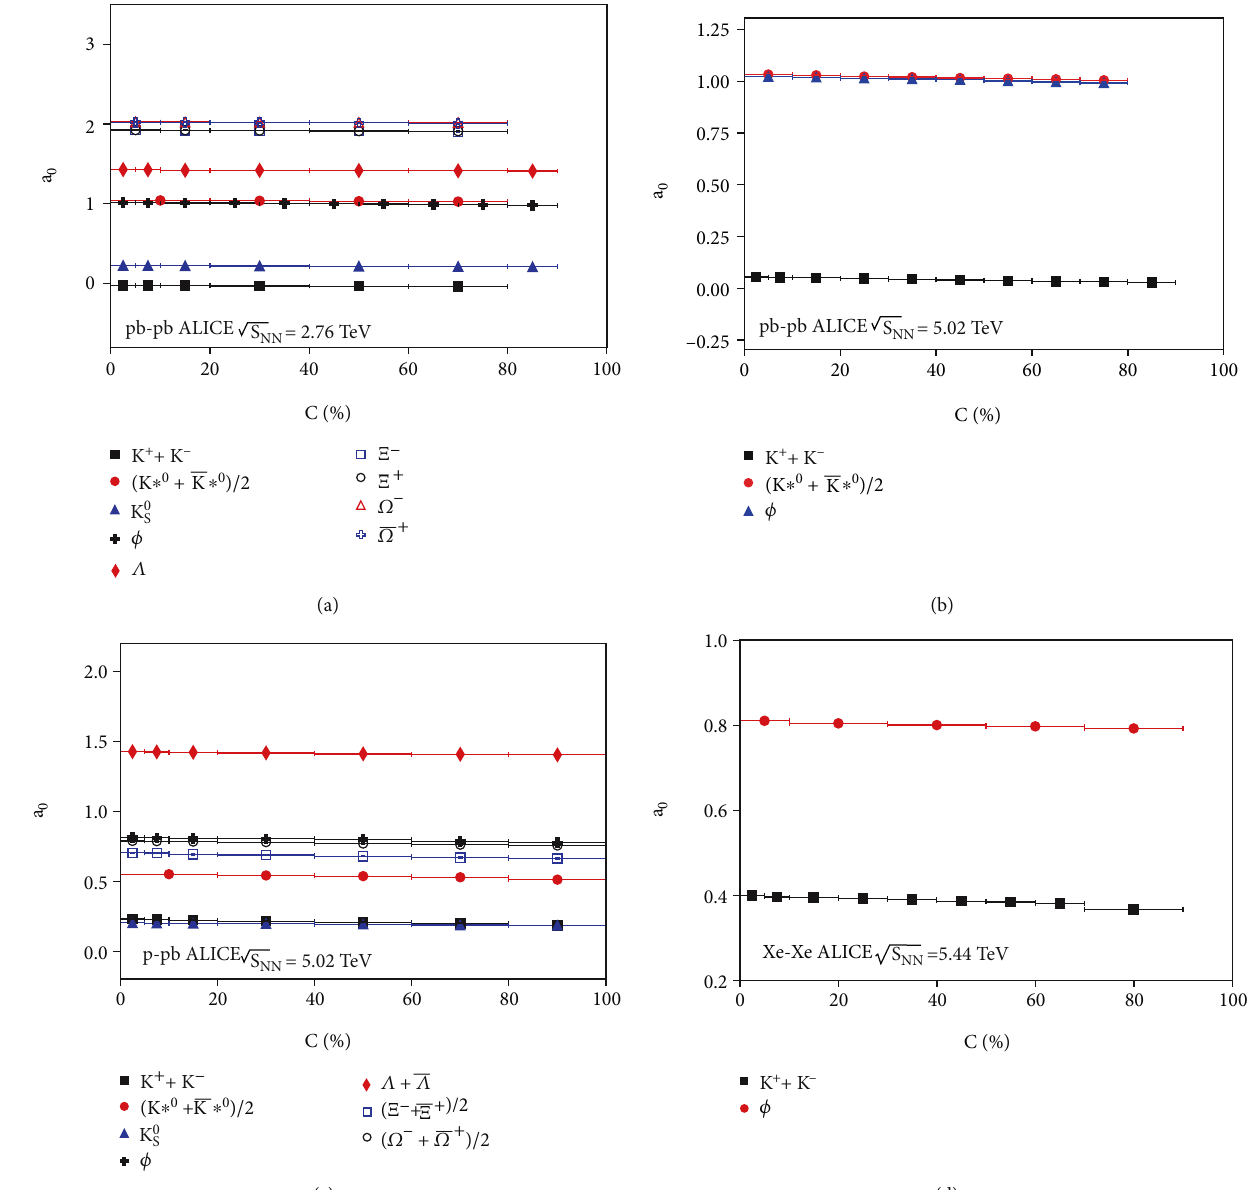
C in Pb – Pb, (c) p – Pb, and (d) Xe – Xe 0 on centrality and